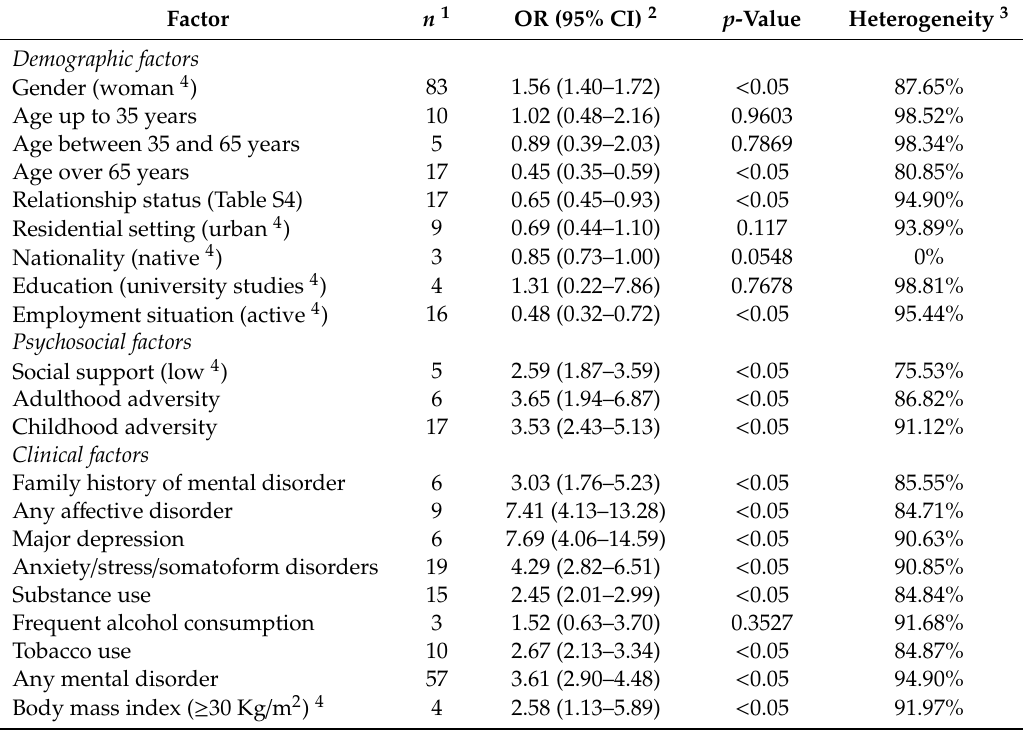
Table 2. Calculated odds ratio for all types of suicidality and all time